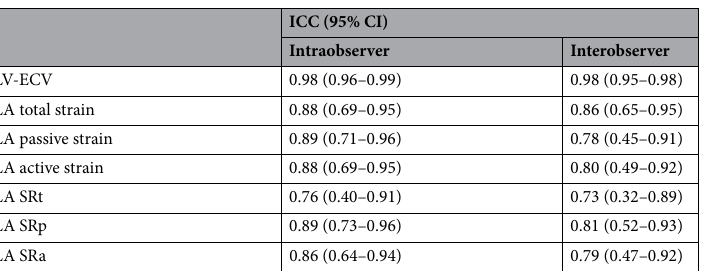
Table 5. Intraobserver and interobserver reproducibility for LV-ECV and LA strain parameters. ECV extracellular volume fraction, ICC intraclass correlation coefficient, LA left atrial, LV left ventricular, SRa peak late negative strain rate, SRp peak early negative strain rate, SRt peak positive strain